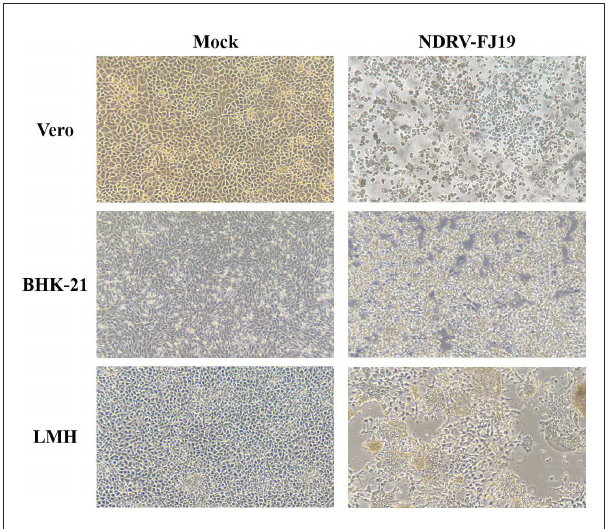
FIGURE1 Growth curve of the NDRV-FJ19 strain in Vero, BHK-21, and LMH cells.